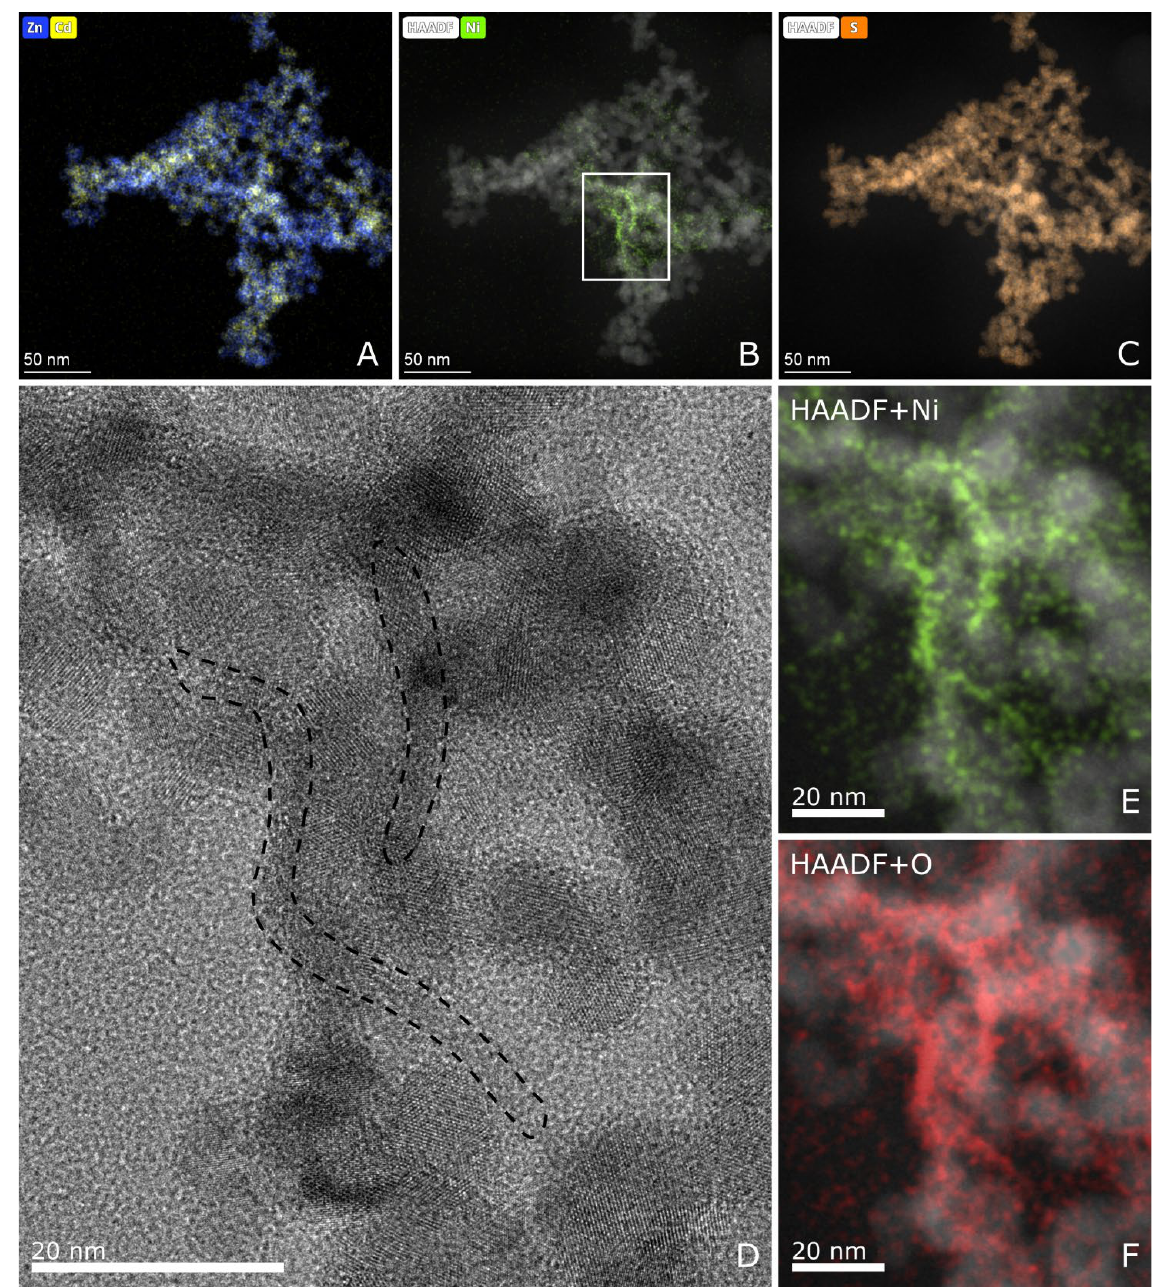
Figure 6. STEM composite images of Cat-4H created from the elemental maps and the HAADF signal ( A – C , E , F ). The HRTEM image ( D ) and the elemental maps ( E , F ) showing the same area marked with the white rectangle on image ( B ). The area outlined by the black dashed line on ( D ) shows the Ni-rich zones. Figure S5 in the Supplementary Materials shows similar STEM images of Cat-4E.